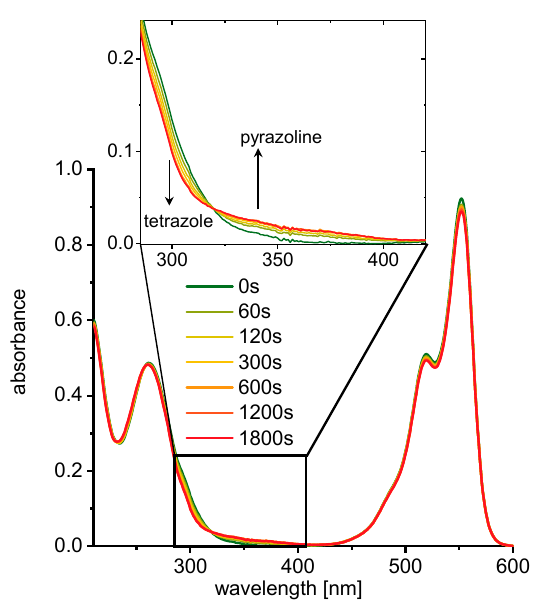
Figure 2. UV/Vis absorbances recorded during irradiation of RNA1 (2.5 μ M) with 1.50 equiv. AF555- Figure 2. UV / Vis absorbances recorded during irradiation of RNA1 (2.5 µ M) with 1.50 equiv. maleimide (3.75 μ M) in 10 mM Na-P i buffer (250 mM NaCl, pH 7). AF555-maleimide (3.75 µ M) in 10 mM Na-P i bu ff er (250 mM NaCl, pH